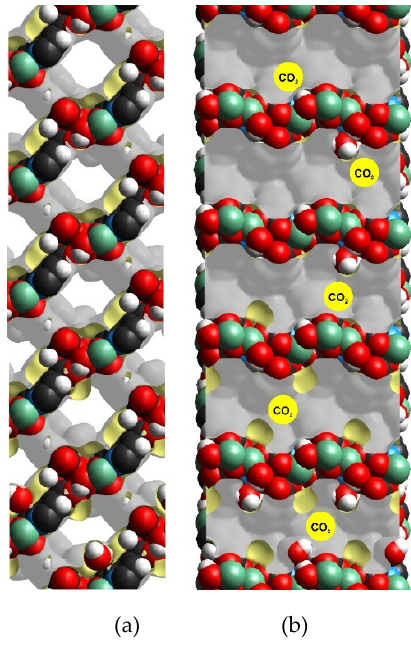
Figure 1. Crystal structures of Mg-CUK-1 with different H 2 O molecule loadings, from top to bottom, none, 1, 2, 4 and 8 water molecules per unit cell. (a) View through the a-axis showing the hydrogen-bonded H 2 O molecules to the hydroxo functional groups (H 2 O···OH- μ 3 ), and (b) side view of the channel (through the c-axis) and accessible surface, yellow circles represent CO 2 kinetic diameter.